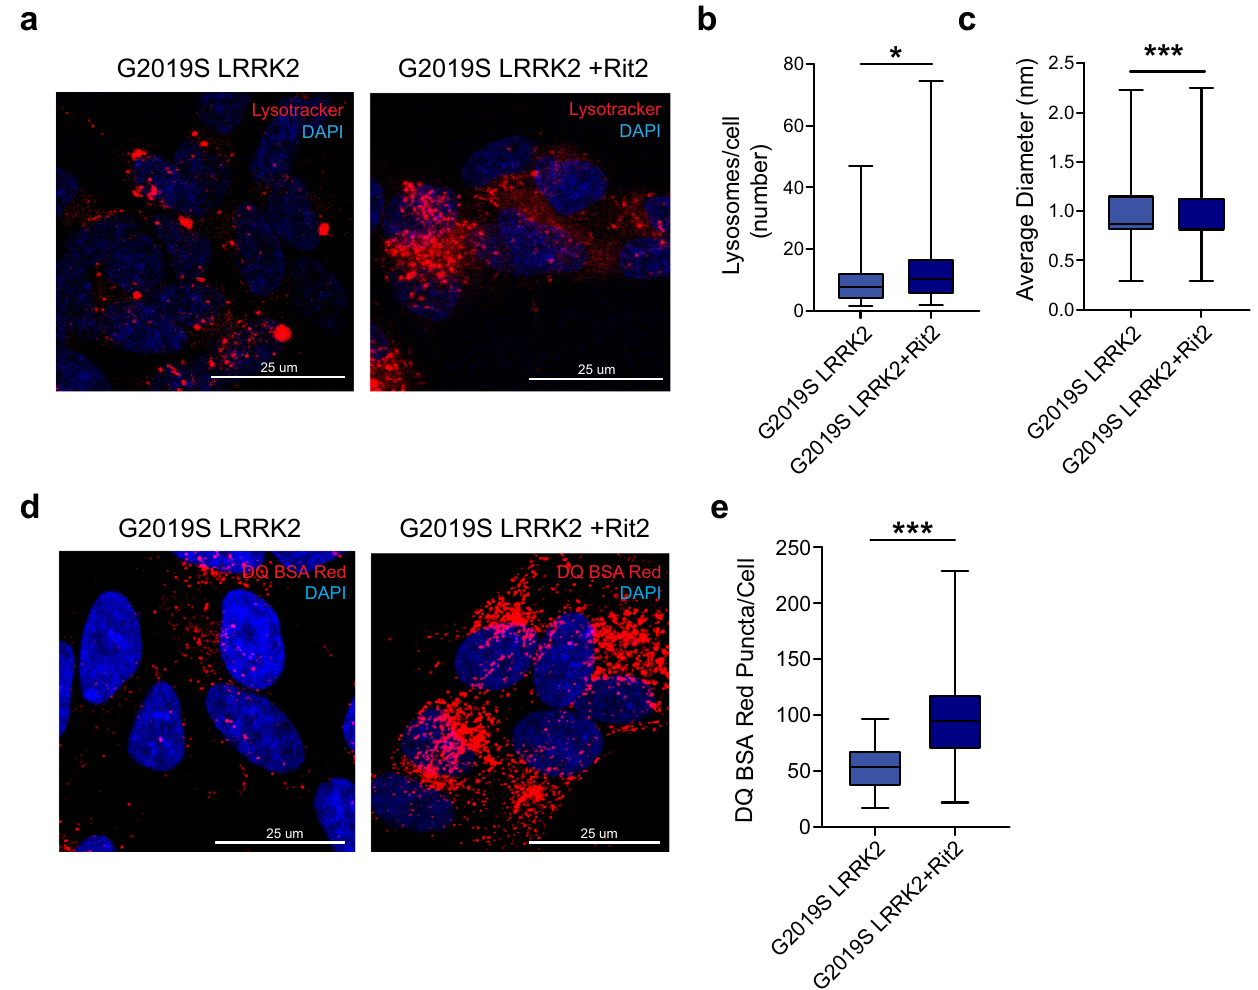
Fig. 3 Rit2 overexpression rescues lysosomal morphology and proteolytic activity in G2019S-LRRK2 cells. a Cell processing with the Lysotracker Red dye was performed to visualize lysosomes in G2019S-LRRK2 and G2019S-LRRK2 + Rit2 cells. b The number of lysosomes per cell was quanti fi ed and revealed an increase, when Rit2 was transfected in G2019S-LRRK2 cells ( n = 3). c The average size of lysosomes was assessed, and a signi fi cant decrease of the diameter was measured when Rit2 was transfected to G2019S-LRRK2 cells ( n = 3). d The DQ-Red- BSA assay was employed to assess the proteolytic activity of lysosomes. e Quanti fi cation of DQ-Red-BSA fl uorescent spots revealed a signi fi cant increase in G2019S-LRRK2 cells, with Rit2 overexpression ( n = 3). Data are represented as median, boxes show the IQ and whiskers show min – max. In imaging experiments, analysis was conducted on 700 – 1000 cells per group in each experiment. * p < 0.05, *** p < 0.001, unpaired two-tailed Student ’ s t